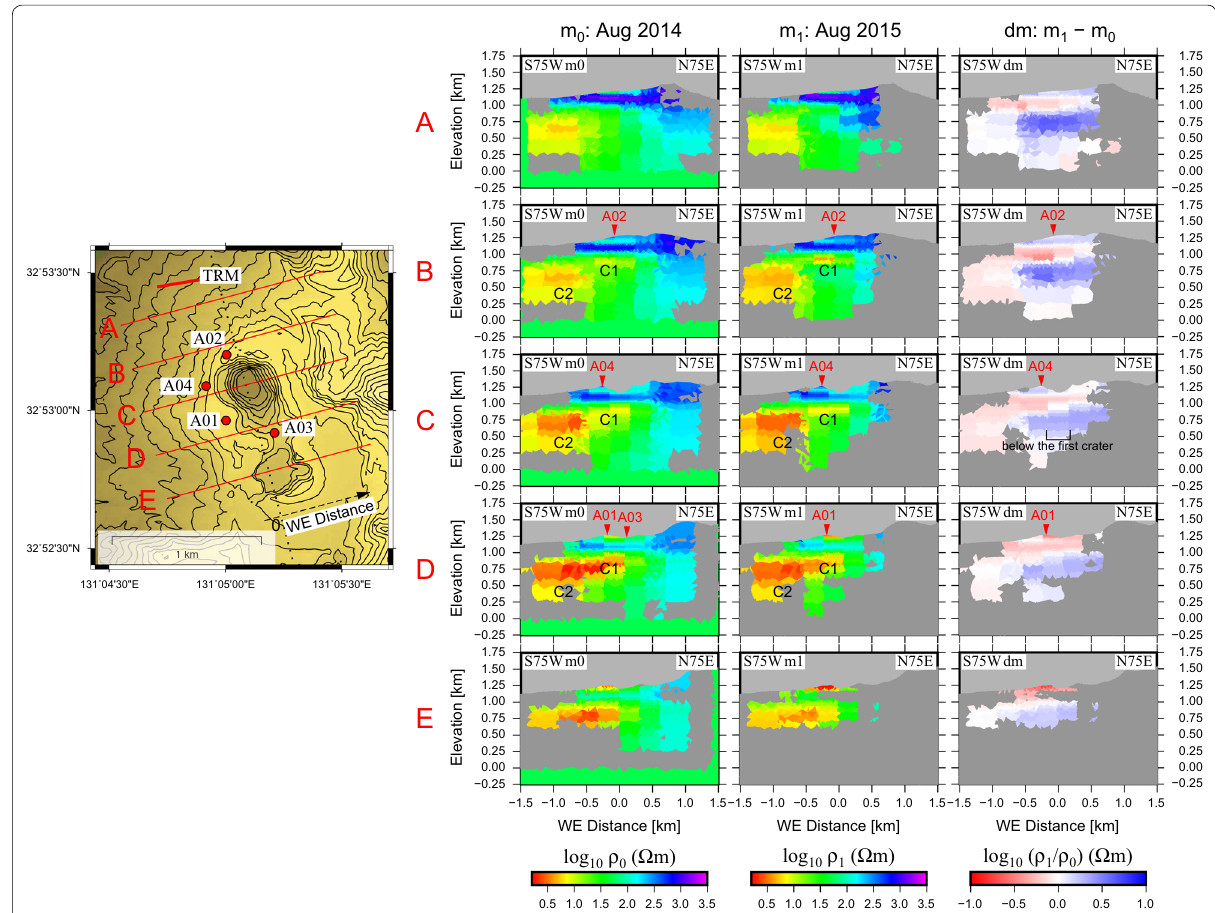
Fig. 2 Vertical slices in the N75°E direction of inversion results using ACTIVE datasets from August 2014 and August 2015. The right column shows the difference between the two inversion results. Red and blue shading corresponds to decrease and increase in resistivity, respectively. For the selection of the masked area, see Additional file 1: Fig.